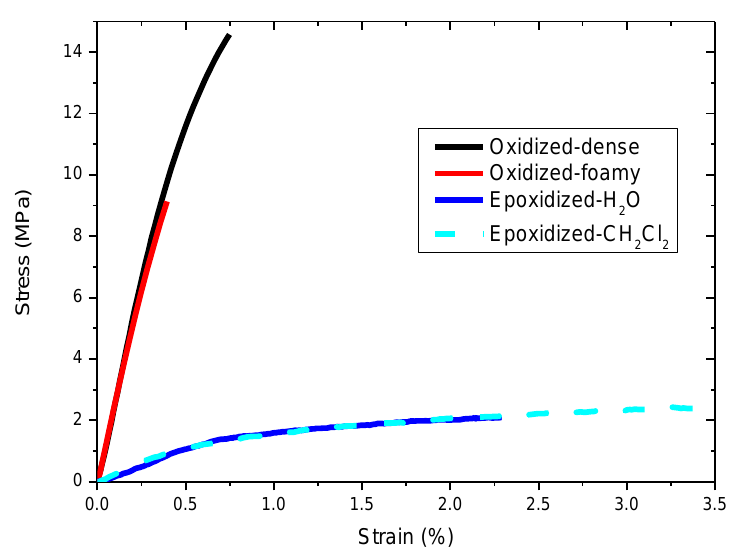
Figure 5. Tensile curves of the buckypapers.